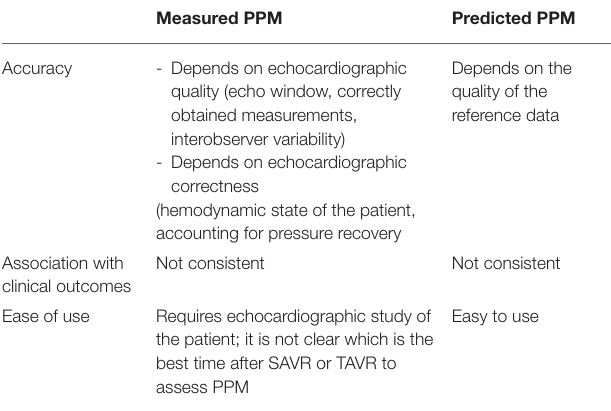
TABLE 2 | Advantages and disadvantages of the use of measured and predicted